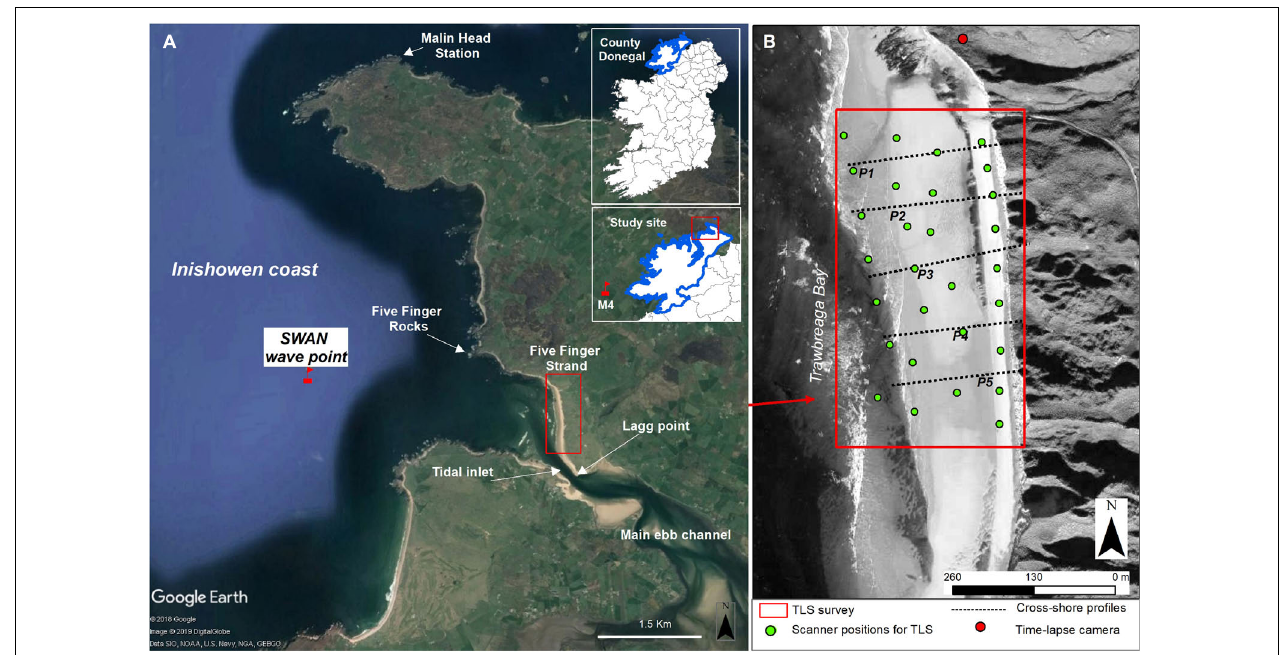
FIGURE 1 | (A) General location of the western coast of Ireland and the Five Finger site showing the M4 wave buoy position and SWAN grid point location. (B) Map of study area in north-western Ireland showing location of the TLS survey, time lapse camera and cross-shore